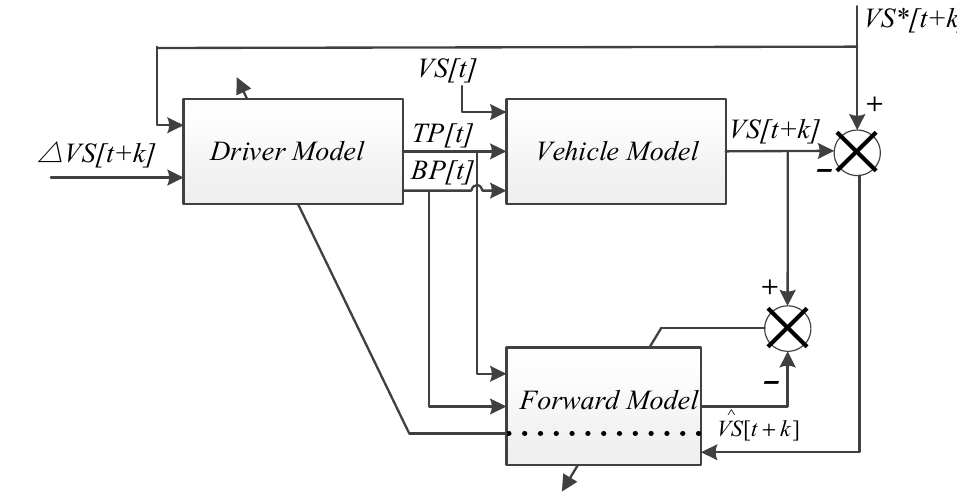
Figure 1. Block diagram of driver modeling [25].